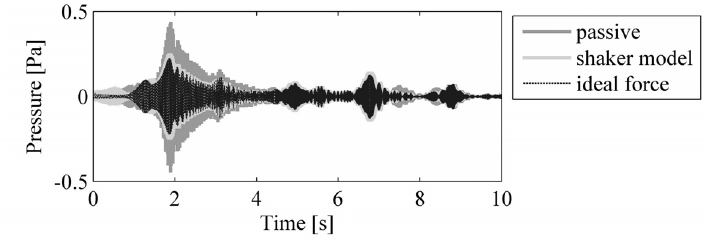
Fig. 11. Pressure at the drive’s head position for different conditions (G = 450 V/(m/s)).